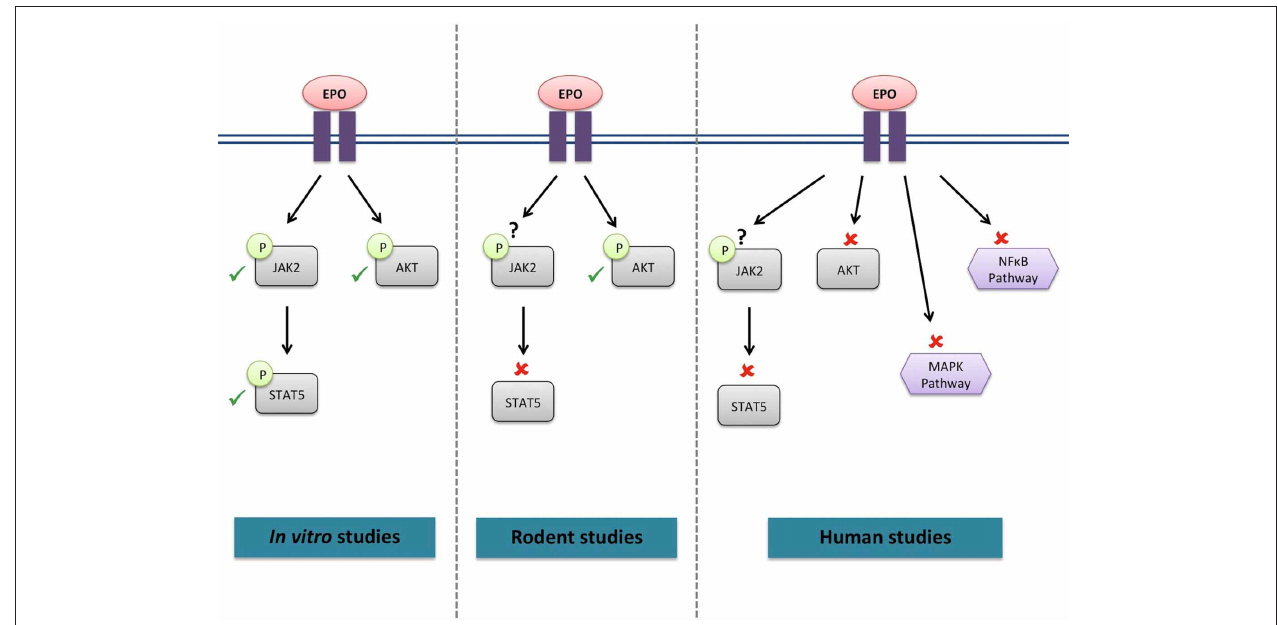
FIGURE 1 | Signaling cascades activated by EPO in skeletal muscle. (cid:2) , activated by EPO; ✘ , not activated by EPO; ?, not investigated.